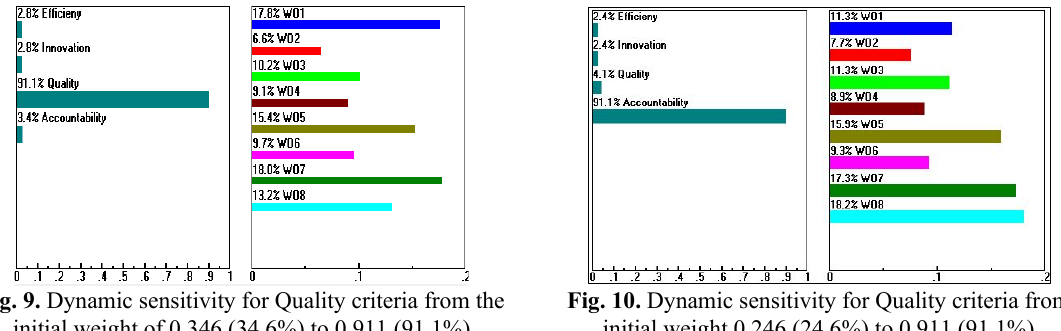
Fig. 10. Dynamic sensitivity for Quality criteria from initial weight 0.246 (24.6%) to 0.911